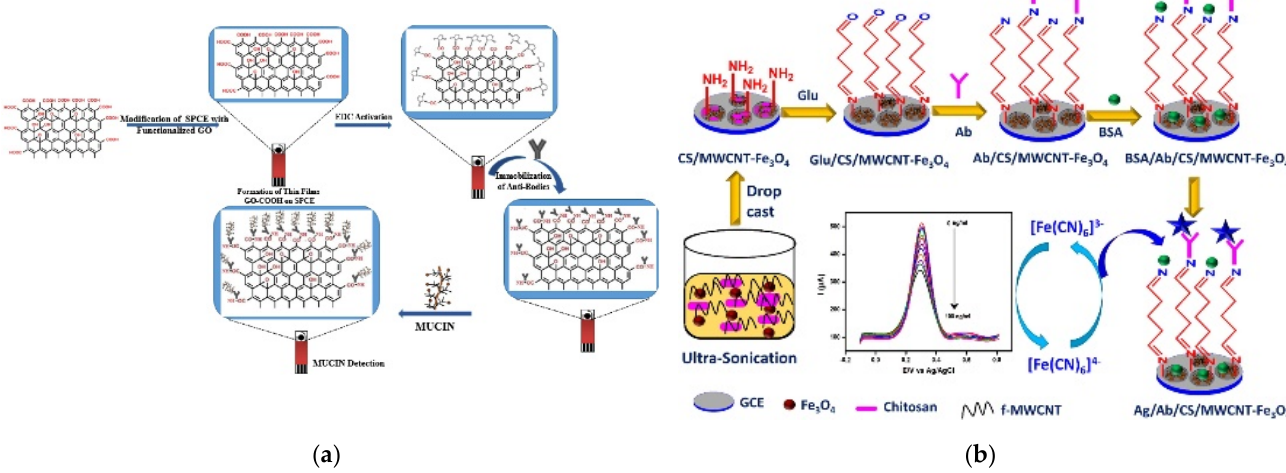
Figure 2. Examples of voltammetric immunosensors with covalently immobilized antibodies. ( a ) Immunosensor based on carboxyl functionalized GO. Antibodies were chemically immobilized using EDC chemistry. Reproduced with permission from [44]. Copyright (2018) Elsevier. ( b ) CA19-9 biosensor based on CS-MWCNT-Fe 3 O 4 . Antibodies were immobilized using glutaraldehyde. Reproduced with permission from [46]. Copyright (2021) Elsevier.